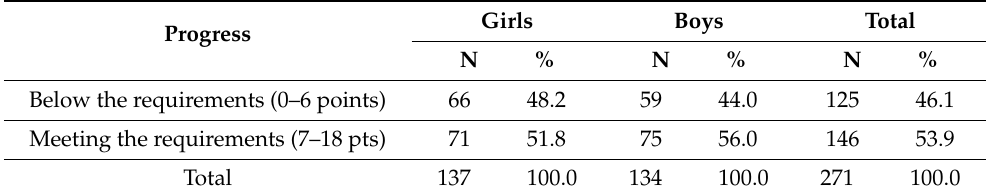
Table 2. Characteristics of 10-year-old children in swimming progress groups.